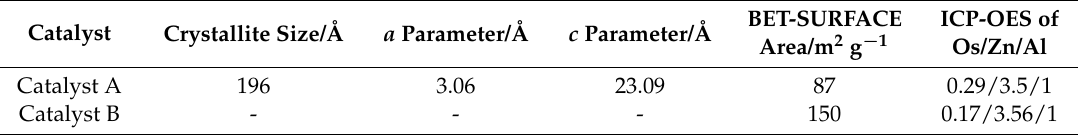
Figure 1. XRD pattern of Os – hydrotalcite-like compound (HTlc) ( a ) and Os – HTlc treated at 300 °C ( b ) obtained with Cu source ( λ = 1.5406 Å). Table 1. Chemical and physical properties of temperature (un)treated Os-HTlc prepared by co-precipitation for the aminohydroxylation reaction of olefins.